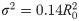
Equilibrium distribution of donor-acceptor separation distances.The results of simulated steps of the acceptor-donor labels of the polymer diffusion (histogram) are compared with the predicted distribution of separation distances from Eq (12) (red-curve). Results are obtained from 1.8 × 106 sampled simulation steps fit with mean μ = R0 and variance σ2=0.14R02.